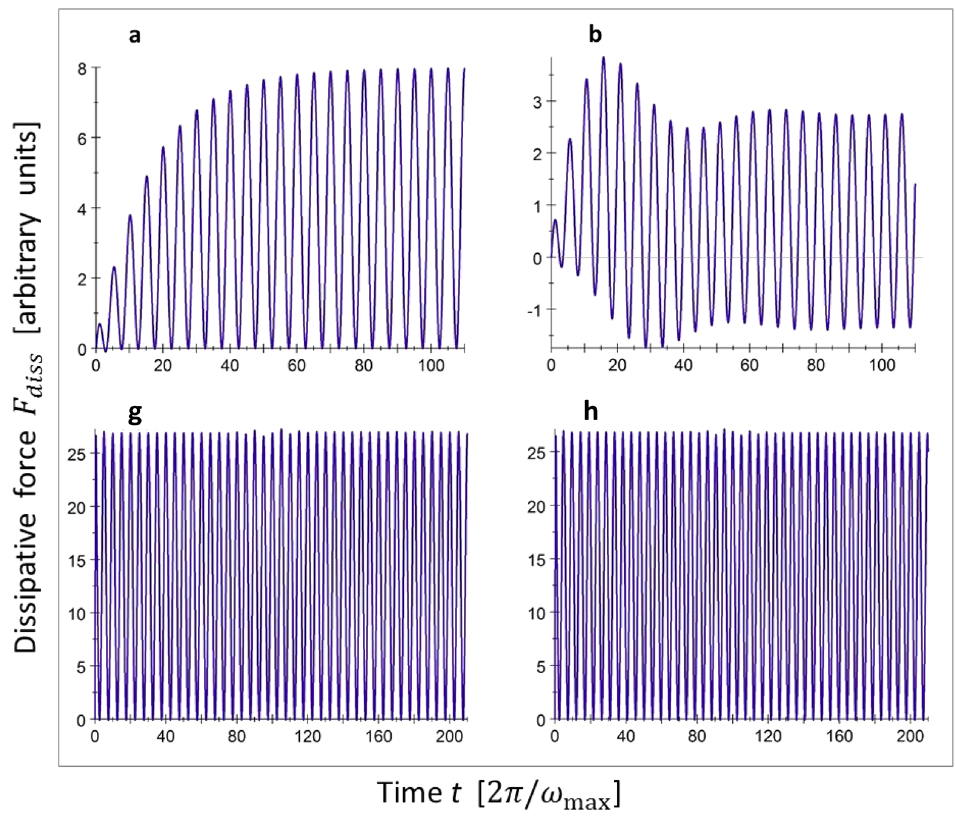
Figure 4. Similar to Fig. 3, but taking into account finite lifetimes of all phonons of 10 vibrational periods, Ŵ = 10 (see text). The labels refer to the corresponding panels of Fig.